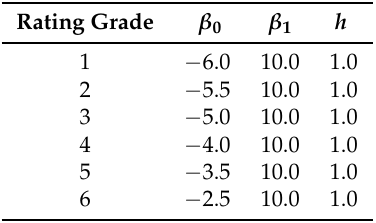
Table 2. Parameters for the Cox proportional hazard model for each rating